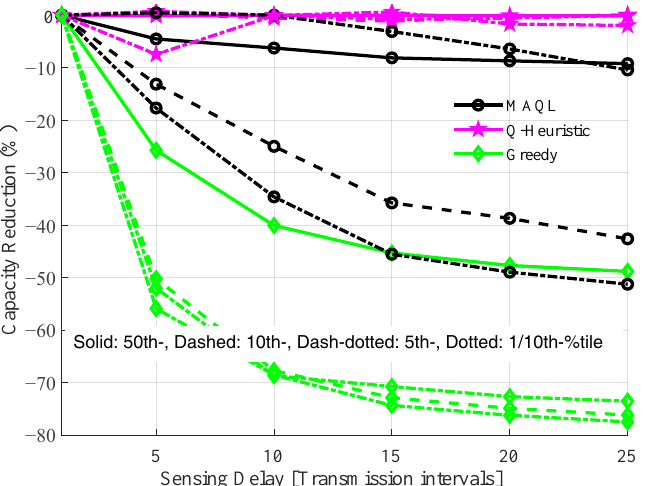
Figure 9. Sensitivity of joint channel and power selection methods to sensing delay, τ with s th = 2